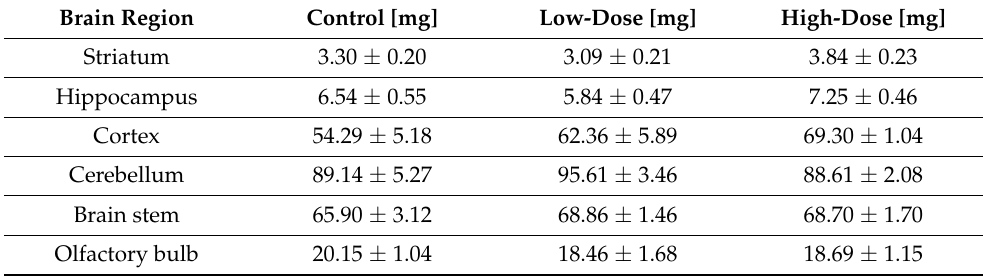
Table 1. The weight of each part of